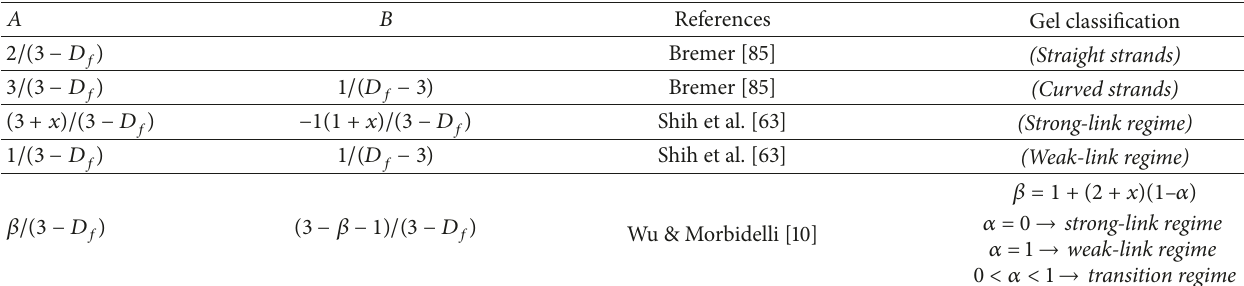
Table 1: Scaling models for determining fractal